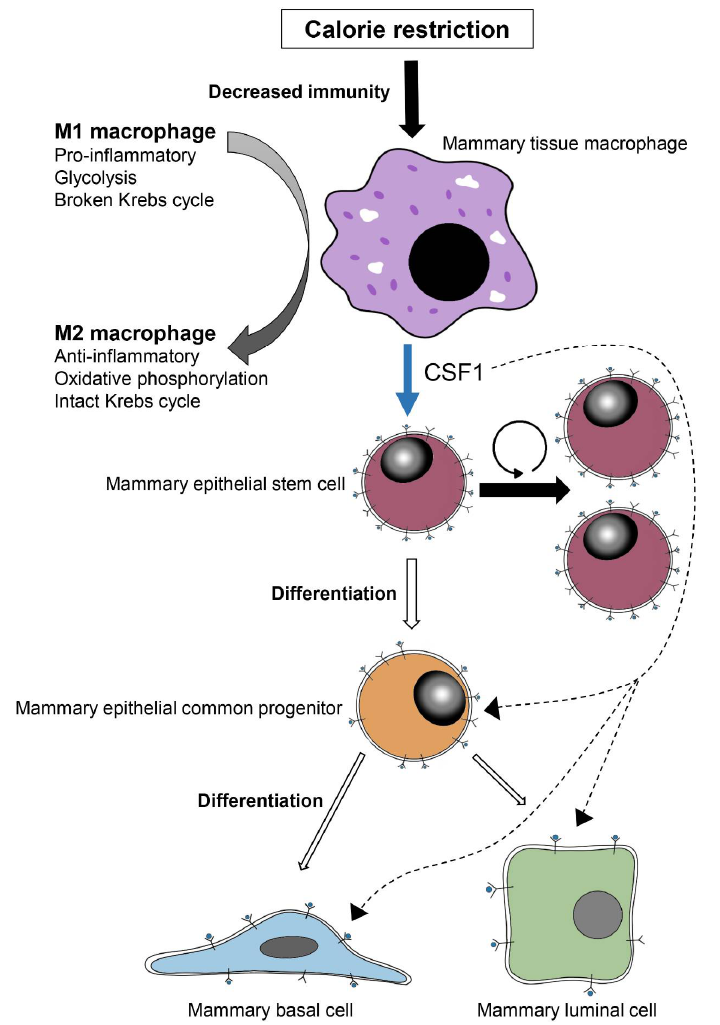
Figure 9. Scheme summarizing study results. The decrease in energy flow to the mammary gland due to calorie restriction (CR) is detected by the residing macrophages and translated into polarization toward the M2 anti-inflammatory and more economic macrophage phenotype. Expression and secretion of CSF1 are then induced. The CSF1 binds CSF1R, which is highly expressed on the surface of the mammary epithelial stem cells (MaSCs), promoting their self-renewal. A distinct effect of CSF1 on mammary epithelial progenitors and their differentiated luminal and basal descendants is probable but was not investigated in this study.